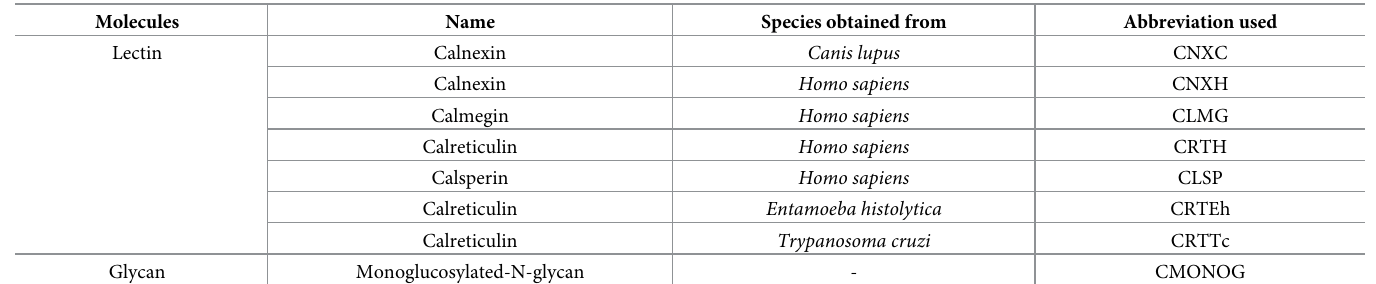
Table 1. Seven molecular systems used in this study for molecular dynamics simulations and analysis.